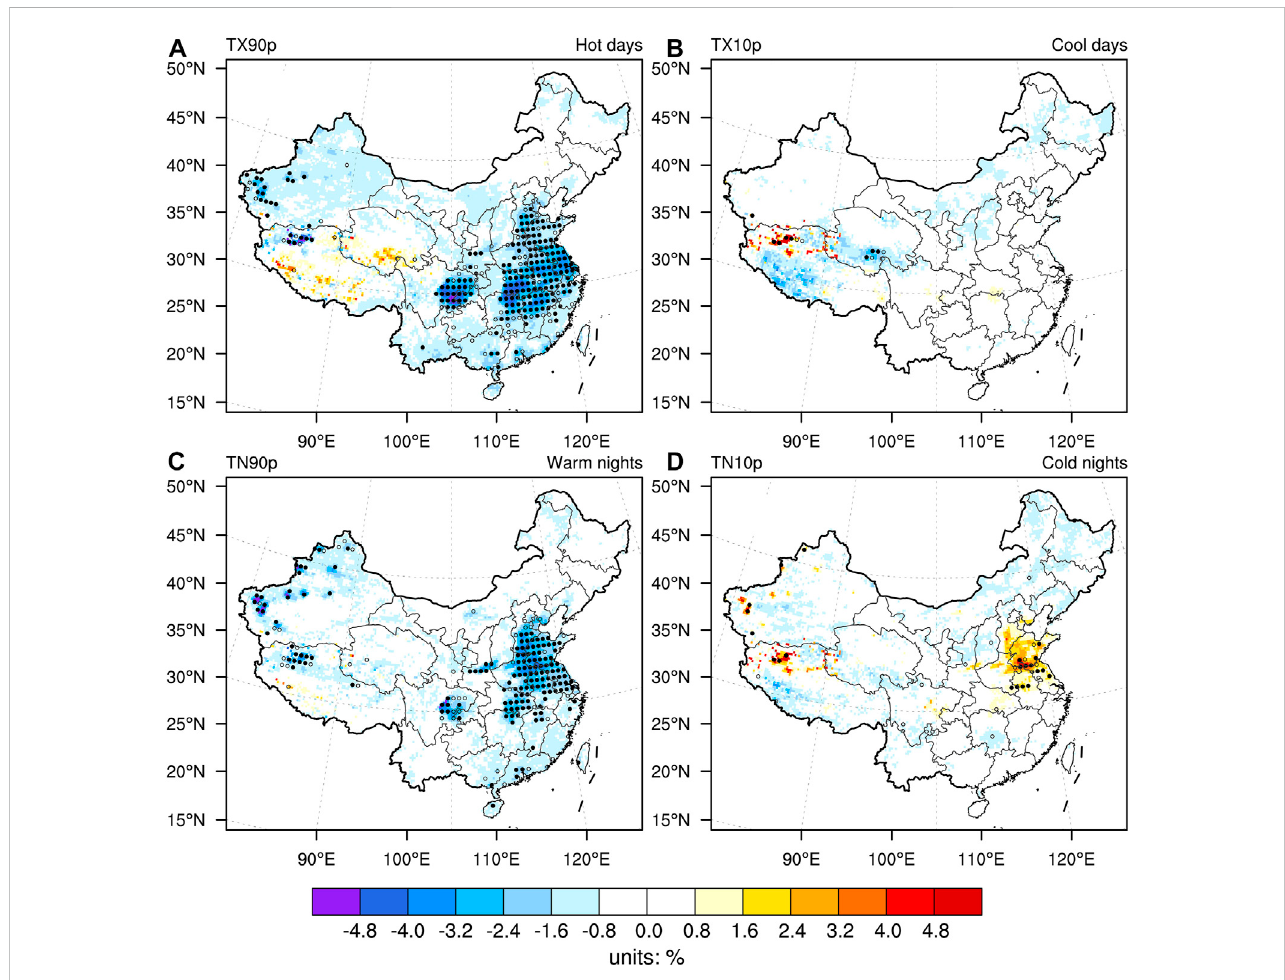
FIGURE 5 Same as Figure 4, but for percentile-based indices (units: %): (A) hot days (TX90p), (B) cool days (TX10p), (C) warm nights (TN90p) and (D) cold nights (TN10p). The meanings of solid and hollow dots are the same as Figure 3.